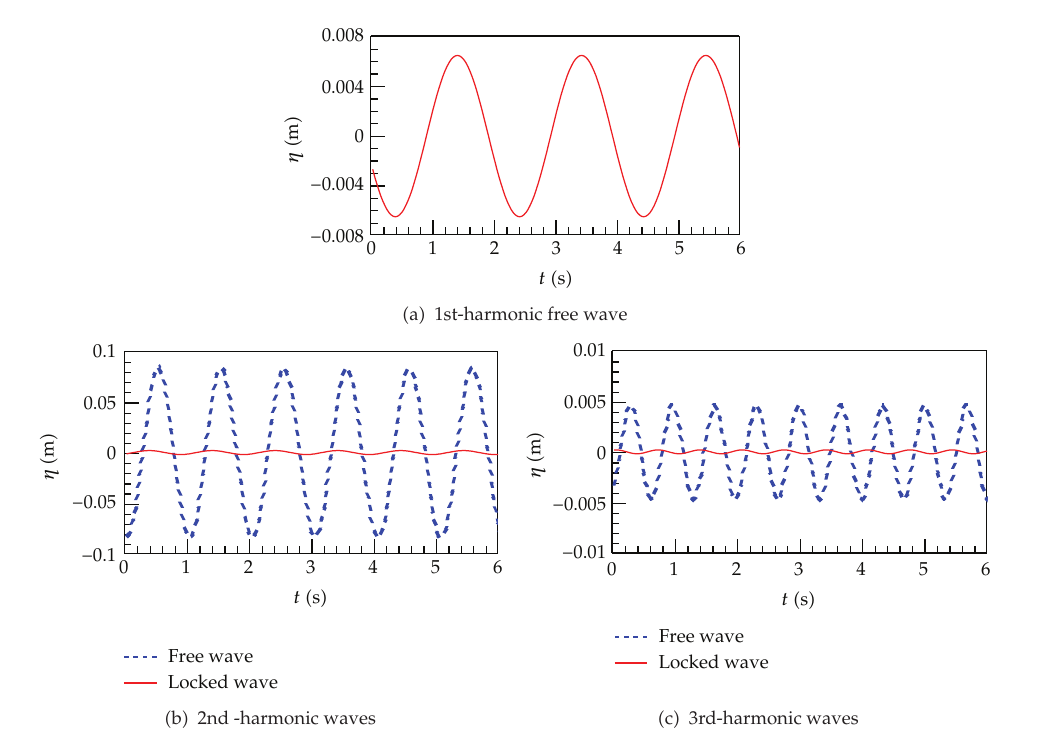
Figure 7: Time histories of various order harmonic waves for strong nonlinear condition (cid:2) A (cid:9) 0 . 01m, h (cid:9) 0 . 4m (cid:3) .